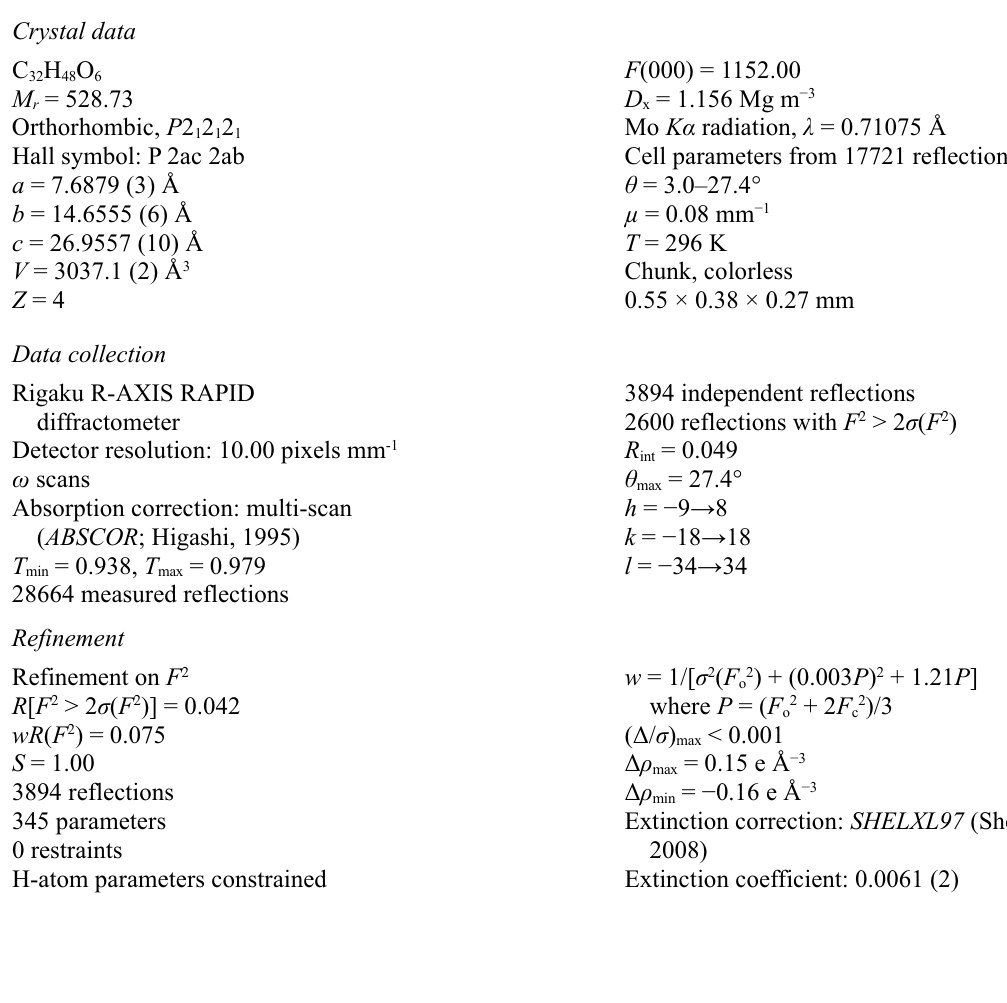
Figure 1 The molecular structure of (I), with atom labels, showing 40% probability displacement ellipsoids. 11 β -hydroxy-24,25-epoxy-3,16-oxo-protost-13 (17)-en-23-yl